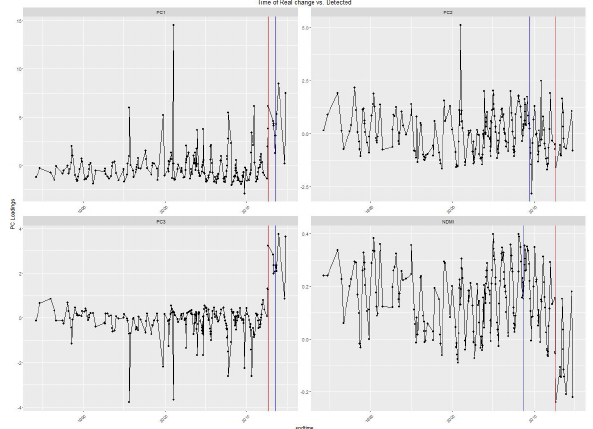
Table 2: confusion matrix. Temporal detection delay is by count- ing the number of observation. PCA3 is the score of the 3rd PC that is applied on all the available data. PCA3 history is to com- pute PCA on history period only.